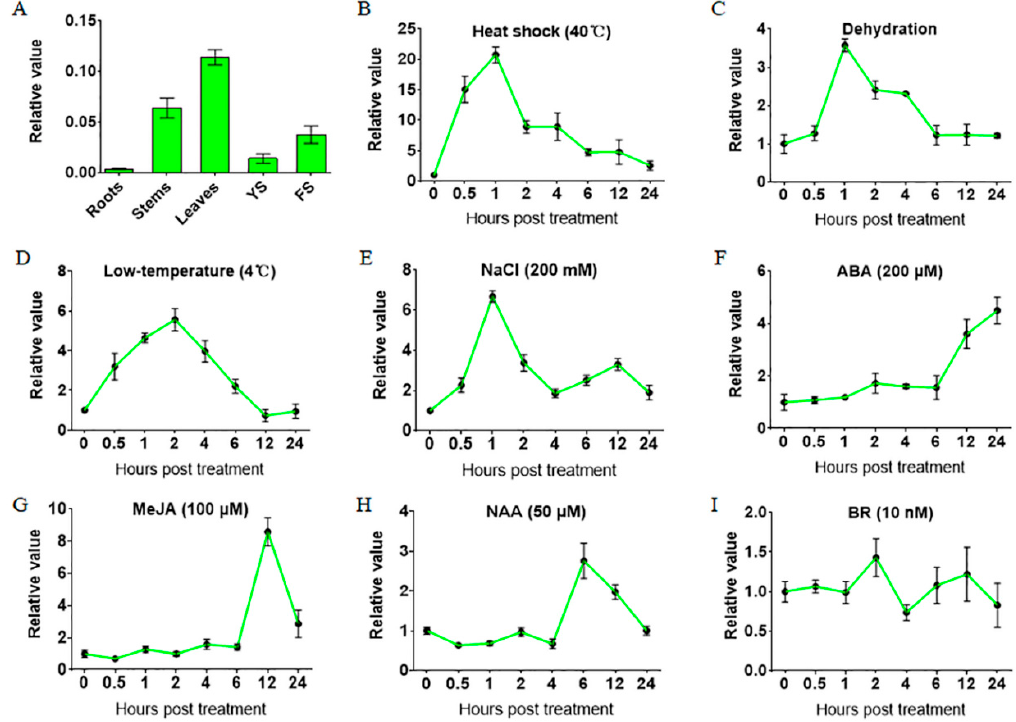
Figure 1. Gene expression patterns of TaHsfA6f . ( A ) Relative expression levels of TaHsfA6f in various wheat organs. Total RNA was isolated from roots, stems, leaves, young spikes (YS), and flowering spikes (FS). The data represent means of three biological replicates ± SD. (B-I) Gene expression patterns of TaHsfA6f during abiotic stresses and phytohormones. Total RNA was extracted from plants treated with 40 °C heat shock ( B ), dehydration ( C ), 4 °C low temperature ( D ), 200 mM NaCl ( E ), 200 µM ABA ( F ), 100 mM MeJA ( G ), 50 mM NAA ( H ), and 10 nM BR ( I ), for the indicated time points. The relative expression level was measured by qPCR and calculated by the comparative CT method. Error bars indicate standard deviations (SD).